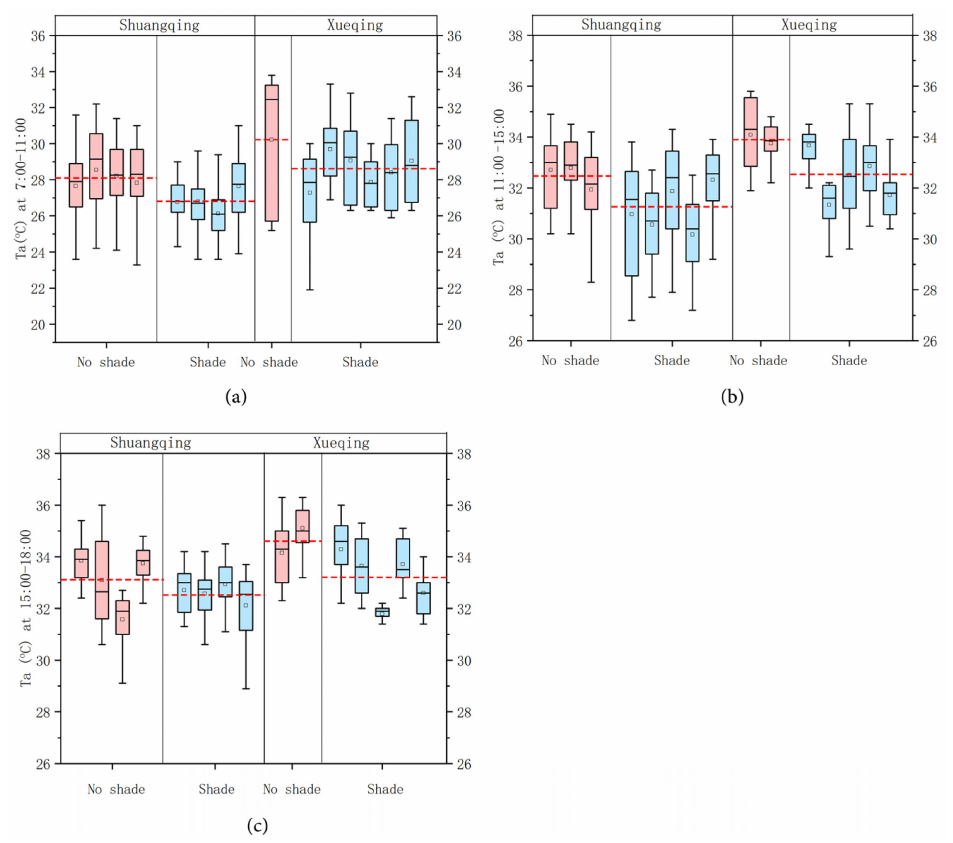
Figure 10. Air temperatures of the observation points with and without shading for 7:00–11:00 ( a